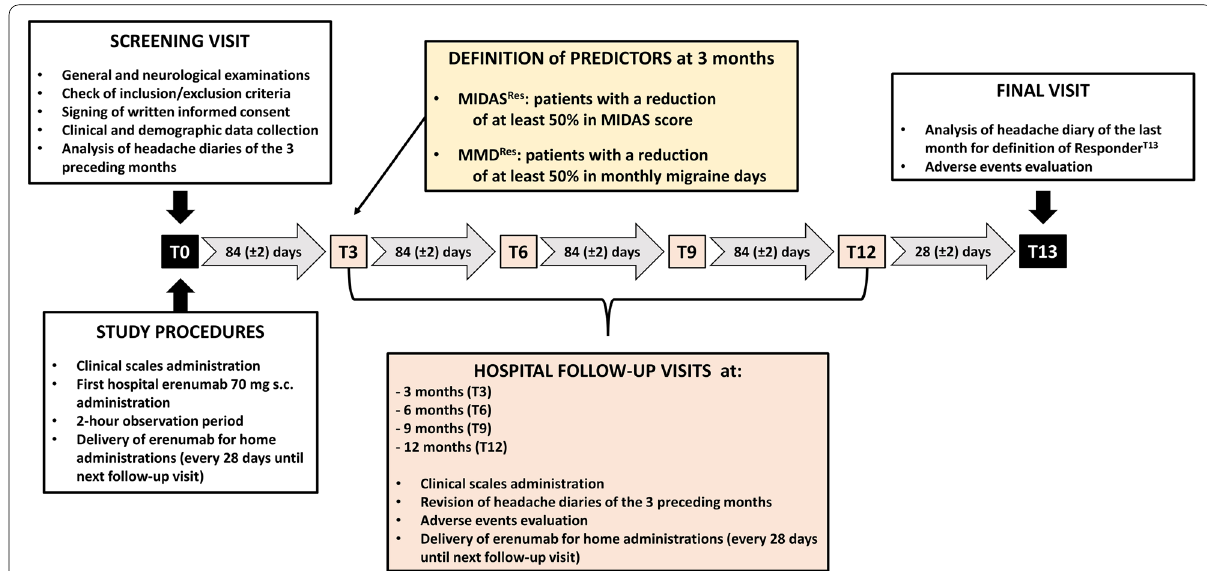
Fig. 2 Timeline and study procedures. MIDAS: MIgraine Disability Assessment. MIDAS Res : Patients with a MIDAS score reduction of at least 50% at T3. MMD Res : Patients with a MMDs reduction of at least 50% at T3. Responders T13 : Patients with a MMDs reduction from baseline of at least 50% in the last 4 weeks of observation period (after 13 erenumab administrations). T3, T6, T9, T12: follow-up visits at three, six, nine, and twelve months after first erenumab